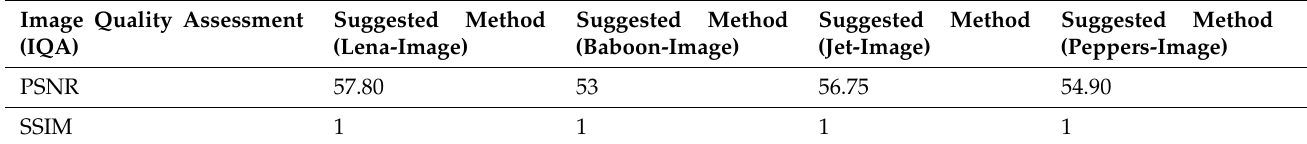
Table 3. Performance